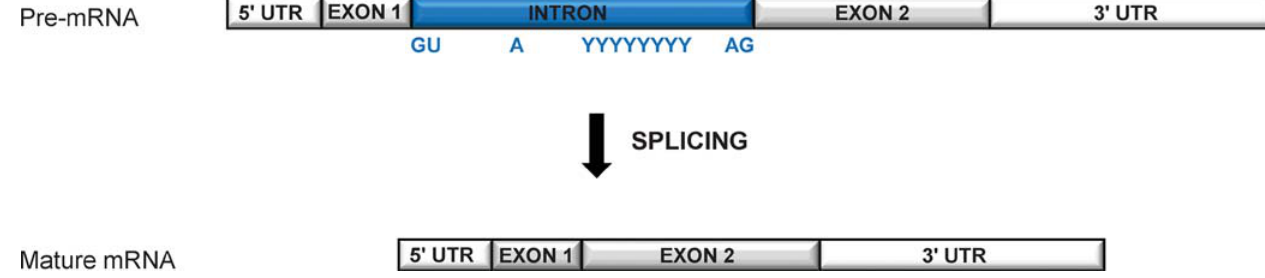
Figure 1. Schematic Example of an Intron-Containing Gene The regions preceding and following the coding regions (exons) are transcribed but not translated, and are called 5′ and 3′ UTRs. The intronic sequence intervenes between the two coding exons and contains splicing signals that are recognized by a nuclear machinery, the spliceosome, which carries out splicing. Splicing signals are located at both ends of the intron (e.g., canonical GU and AG dinucleotides at the 5′ and 3′ splice site, respectively) and within the intron (an adenine residue, called the branch site, and frequently a polypyrimidine (C/U)